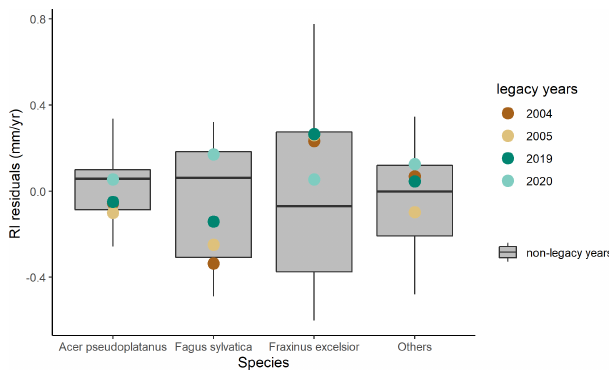
Figure 6. Residuals of RI in legacy years at DE-Hai across species. Residuals of RI are characterised as observed minus predicted RI anomalies (RI residuals). The model uncertainties (the grey area) are characterised as the 25th–75th quantile range of RI residuals in non-legacy years.